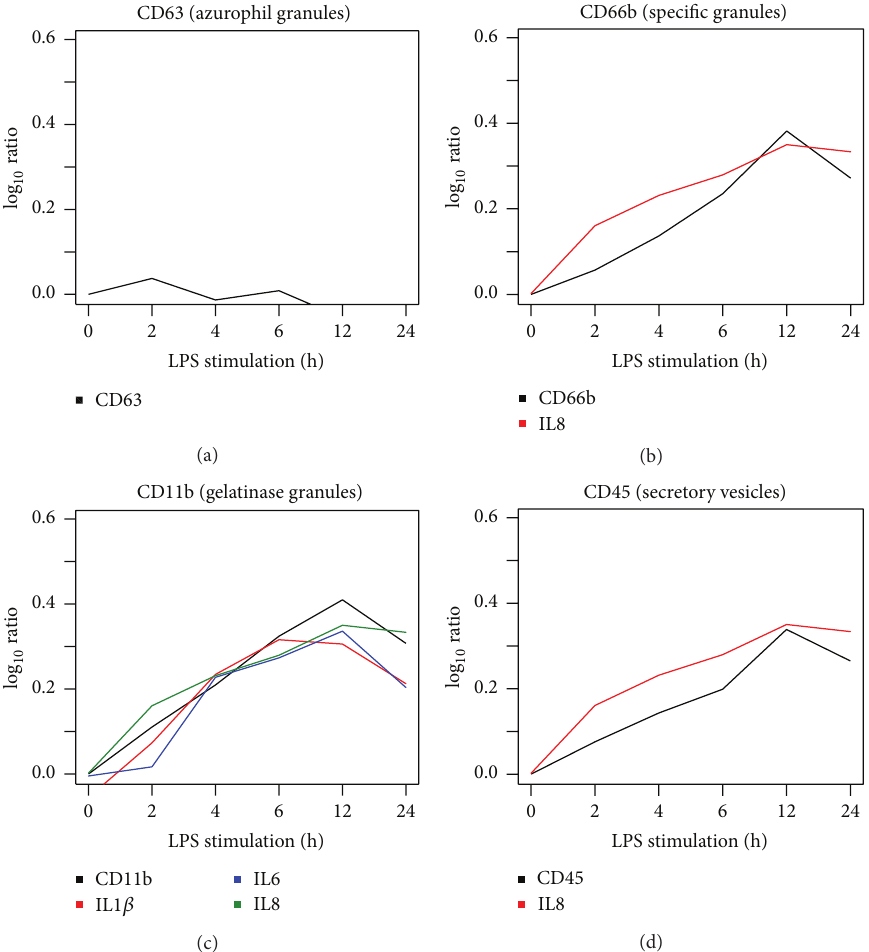
Figure 5: Linear fitting of LPS-mediated kinetics of cytokine release and degranulation in human neutrophils. Enlisted cytokines on the histograms fitted to the kinetics of the degranulation markers characteristic for (a) azurophil granules (CD63), (b) specific granules (CD66b), (c) gelatinase granules (CD11b), and (d) secretory vesicles (CD45), according to the selection of 𝑝 value ≤ 0.05 and RSQ ≥ 0.82.